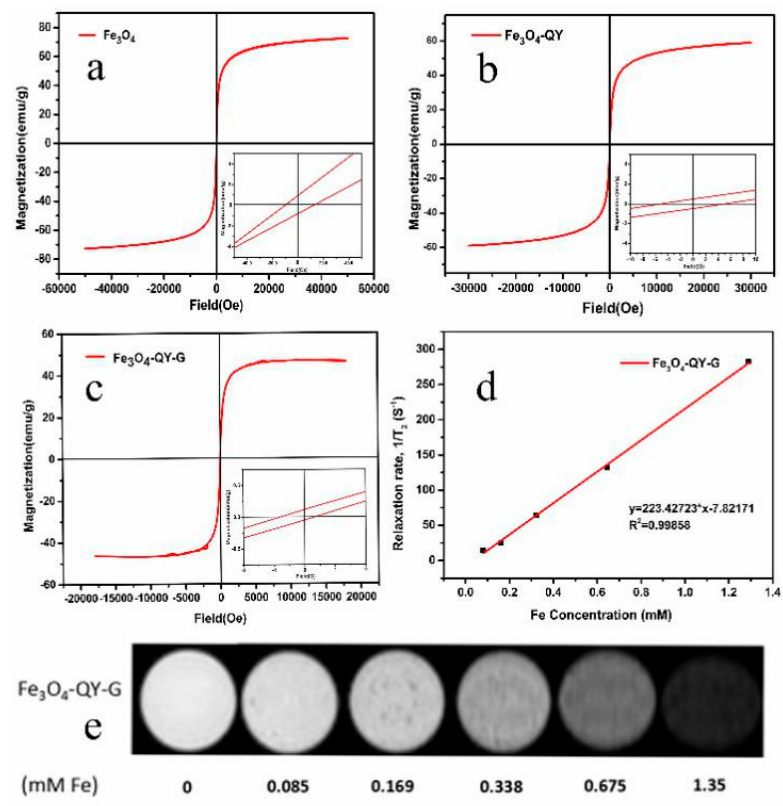
Figure 6. Magnetization curves of ( a ) Fe 3 O 4 , ( b ) Fe 3 O 4 -QY, ( c ) Fe 3 O 4 -QY-G nanoparticles; ( d ) T 2 relaxation rates as a function of iron concentration, ( e ) T 2 -weighted Magnetic Resonance (MR) images of Fe 3 O 4 -QY-G nanoparticles with different Fe concentration.